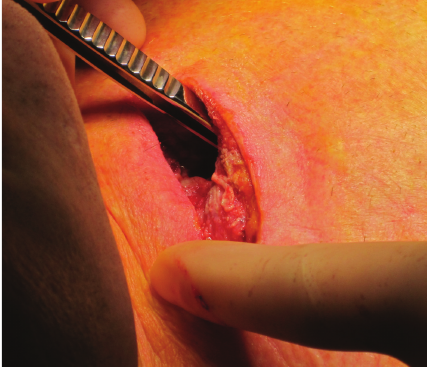
Figure 1: Patient 1. A view of the abscess cavity.